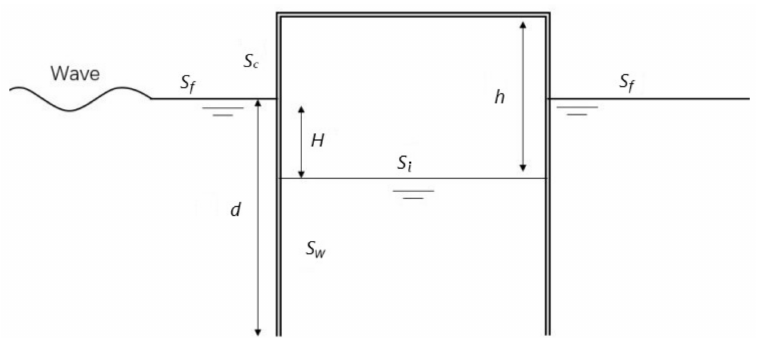
Figure 1. Schematic diagram of a single-cabin rectangular